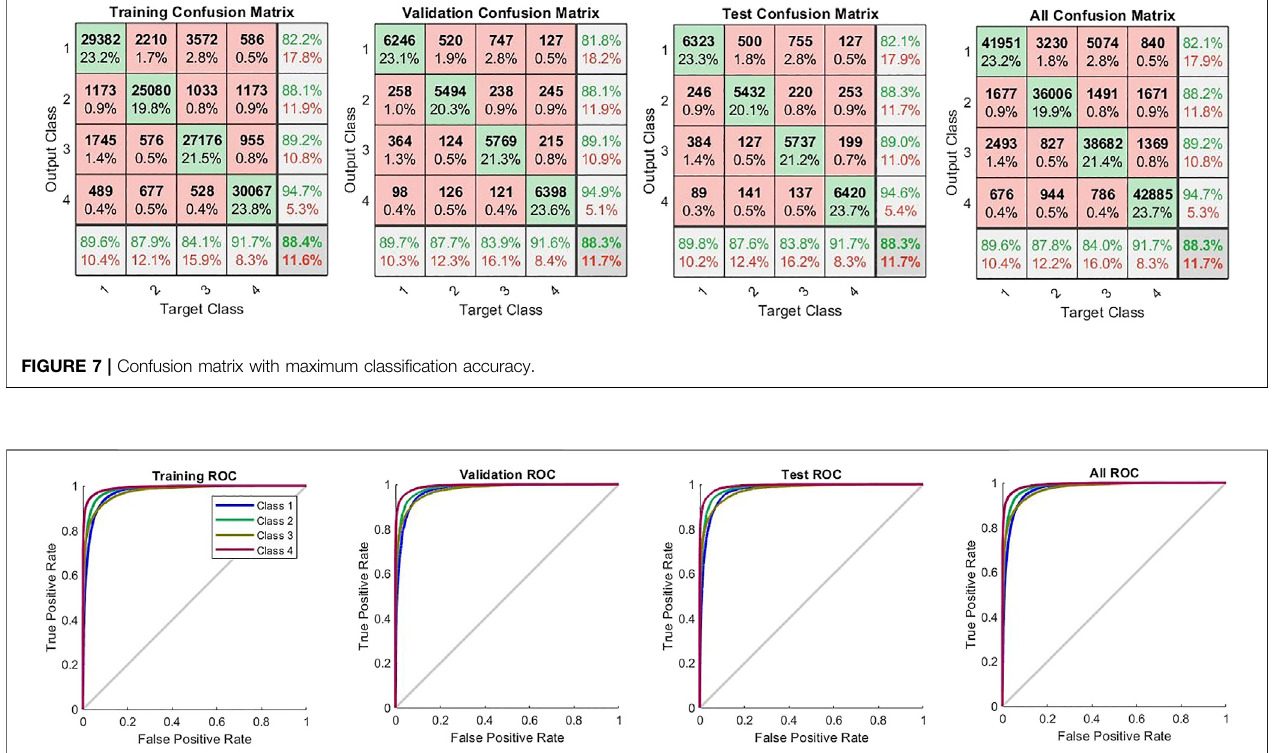
FIGURE 8 | Receiver operating characteristic curve with maximum classi fi cation accuracy.